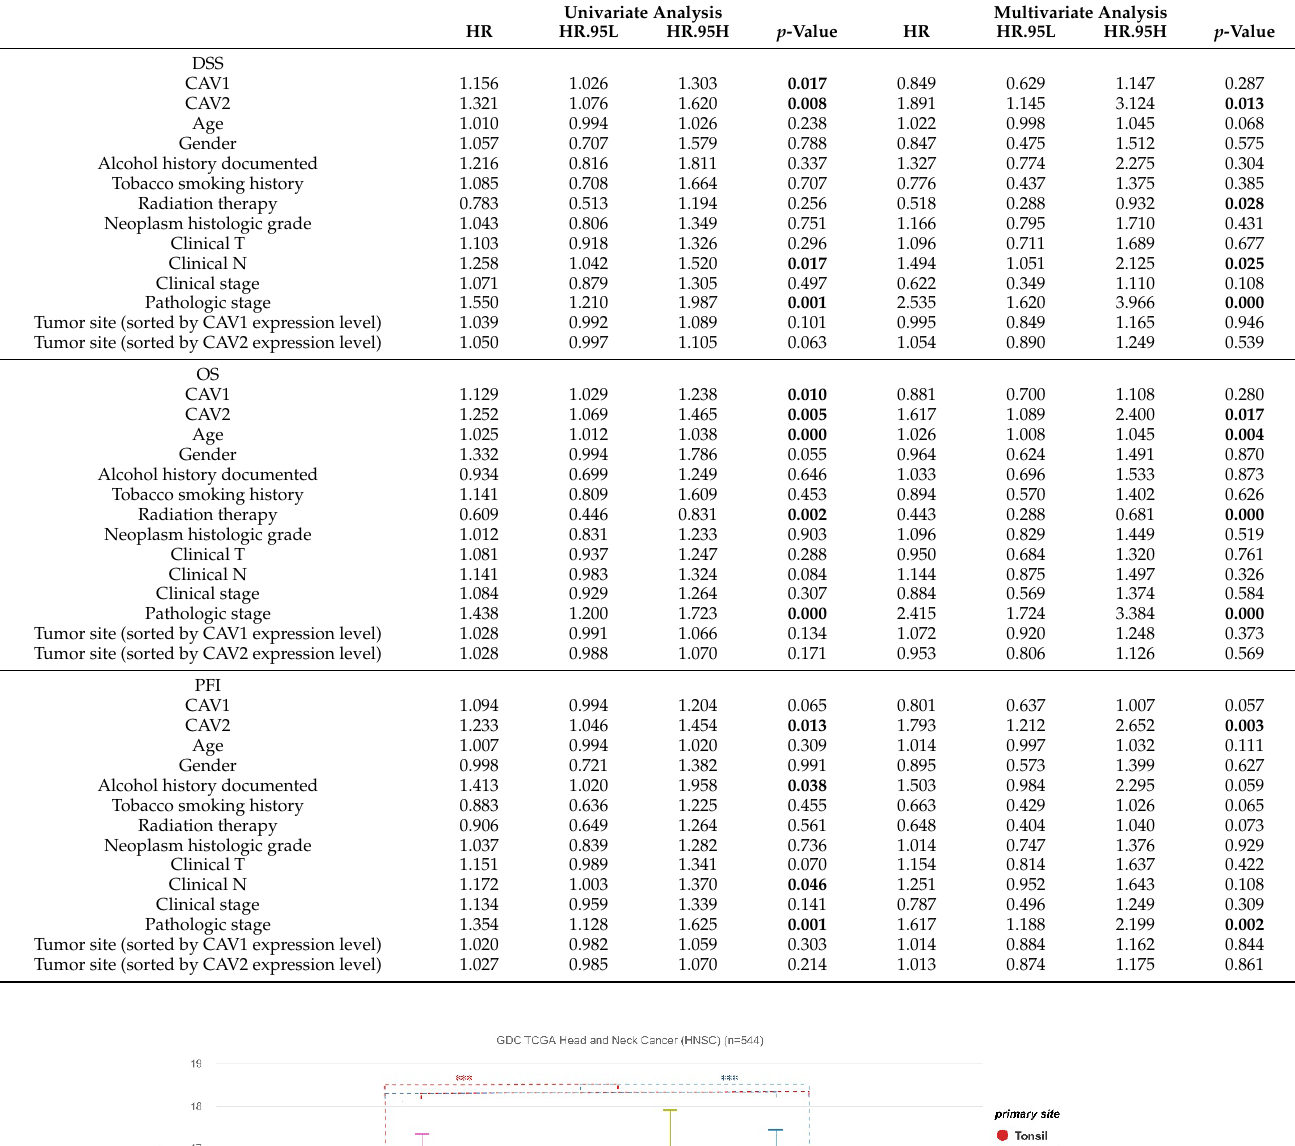
Table 2. Cox regression analysis.